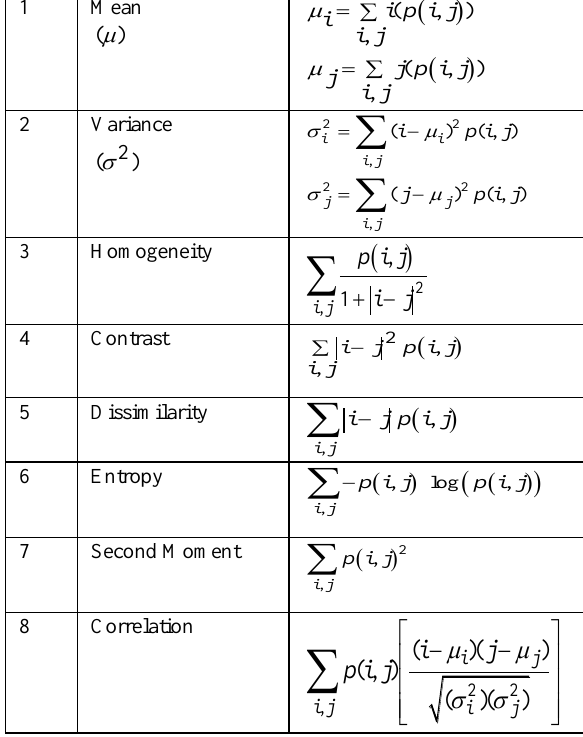
Table 1. GLCM based textural